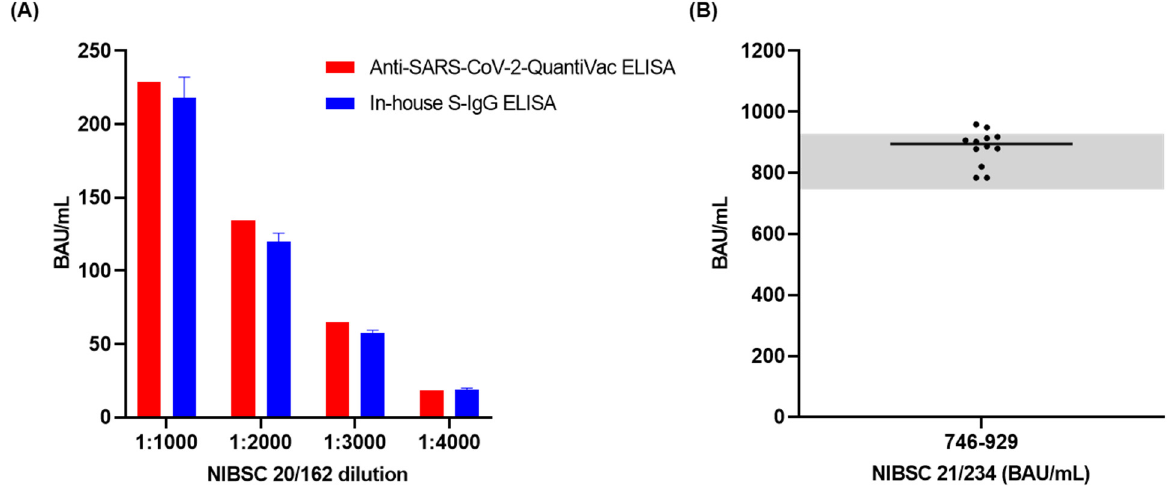
Figure 1. Accuracy of in-house SARS-CoV-2 S-IgG ELISA (blue) determined ( A ) in comparison to Euroimmun, Anti-SARS-CoV-2-QuantiVac-ELISA (red) using NIBSC 20/162 in five replicates and four dilutions (1:1000, 1:2000, 1:3000, 1:4000); standard deviations are shown as error bars (blue) and ( B ) using a standard with known concentration (NIBSC 21/234, 832 BAU/mL) analyzed in twelve replicates on four different days. The grey area indicates the anti-S titer of NIBSC 21/234 of 746–929 BAU/mL (95% CI).